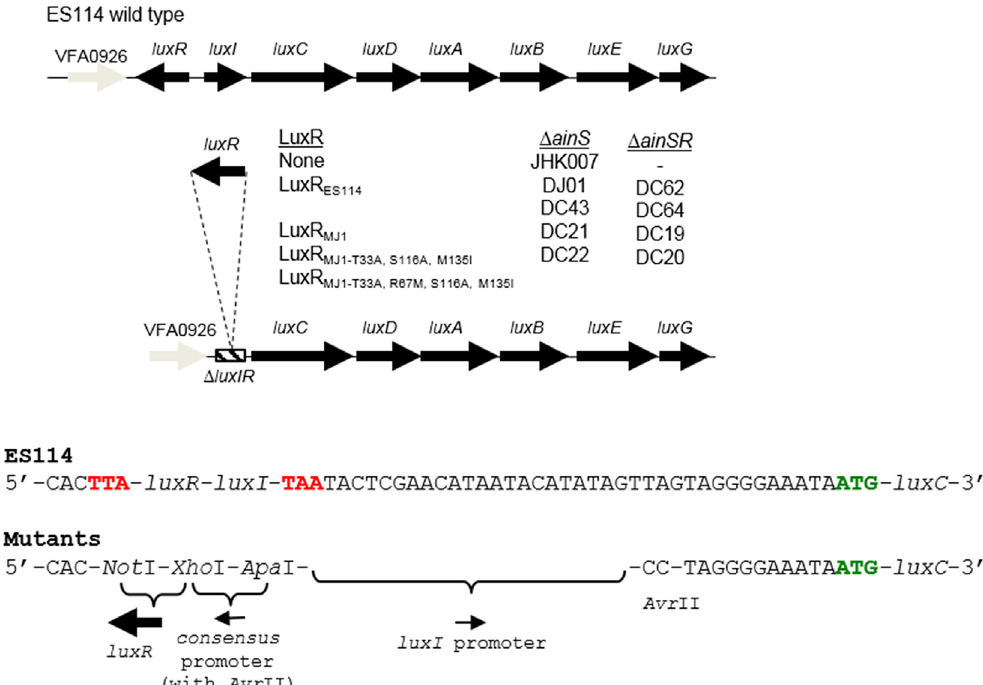
Fig 2. The lux operon in V . fischeri and genomic organization of strains engineered for this study. Panel ( A ) illustrates the genetic structure of the lux locus in parental wild-type strain ES114 (top) as well as the strains used to assay LuxR activity, wherein the native luxRI is deleted and luxR alleles are placed in an engineered construct between ORF VFA0926 and luxC (hatched box). Panel ( B ) shows specific sequences of ES114 aligned with those of engineered strains. Red sequences are stop codons for luxR (reverse strand) and luxI . The green ATG represents the start codon for luxC . Further details (e.g. cloning strategy, sequence of the “ consensus promoter ” , etc.) are provided in Methods